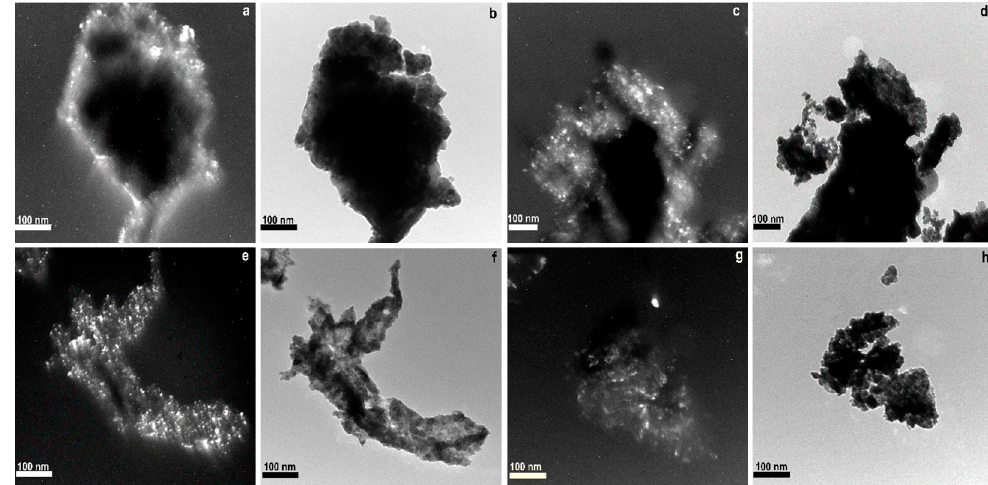
Figure 4. TEM images of Cu/Ce - Ln (Ln: Gd, La, Pr, Nd, Sm) samples. Cu/Ce-Gd: dark-field ( a ) and bright field ( b ) images; Cu/Ce-La: dark-field ( c ) and bright field ( d ) images; Cu/Ce-Pr dark-field ( e ) and bright field ( f ) images and Cu/Ce-Nd dark-field ( g ) and bright field ( h ) images.